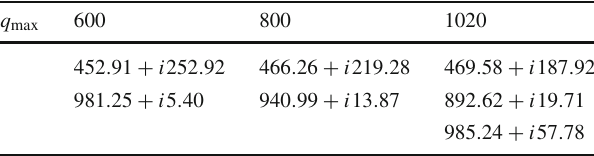
Table 1 Poles for J PC = 0 −+ PP states for the case without η − η (cid:4) mixing. [in MeV]